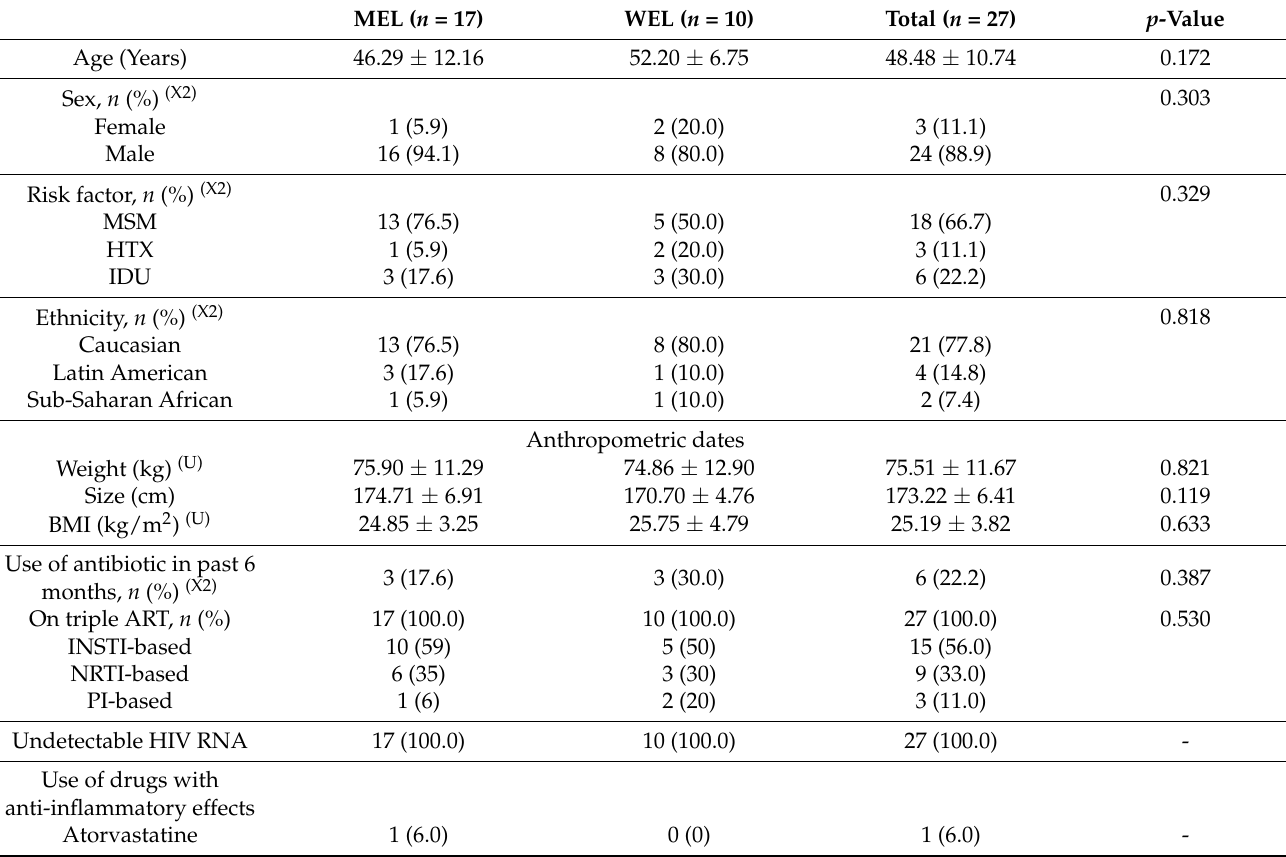
Table 1. Sample characteristics by dietary